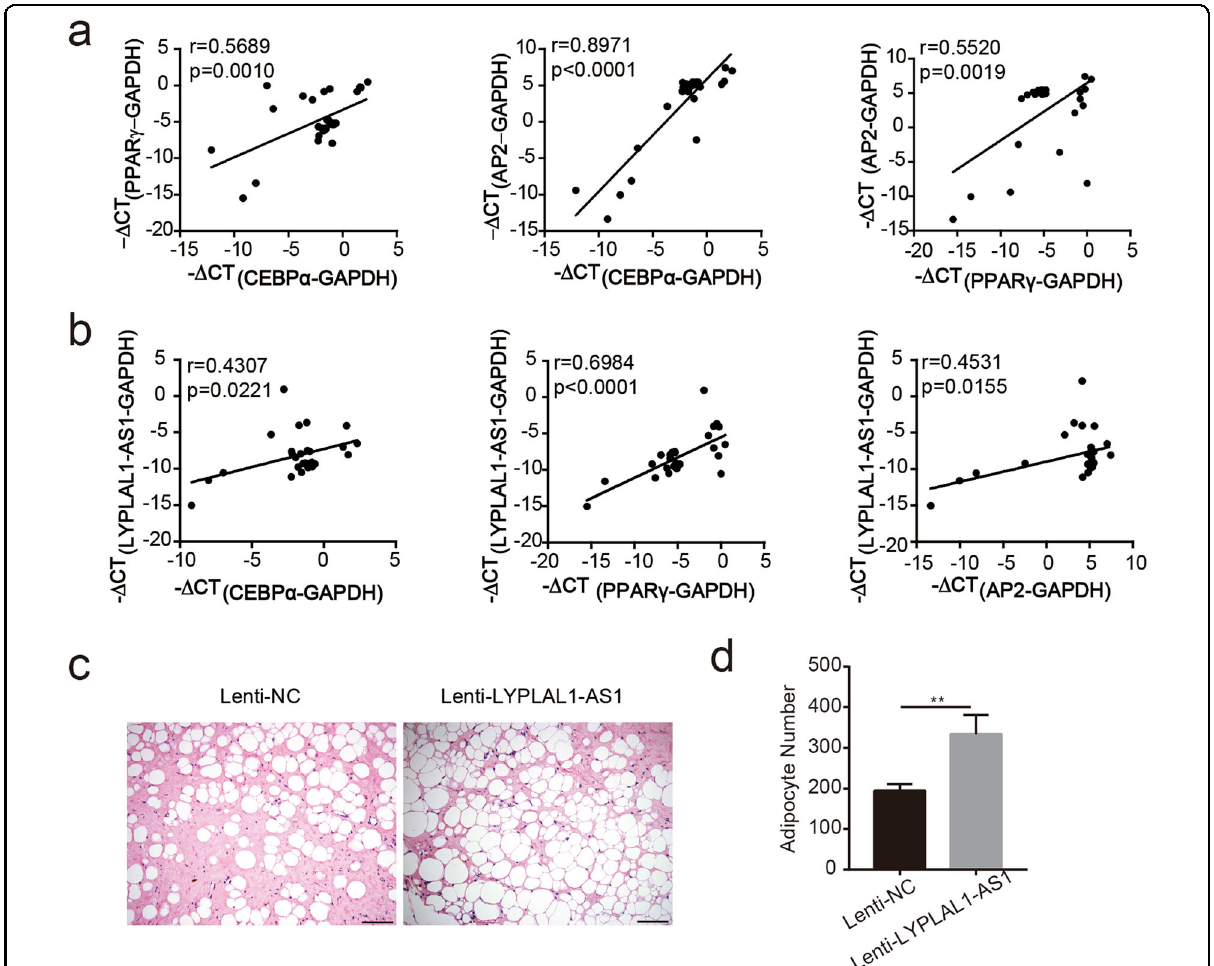
Fig. 3 LYPLAL1-AS1 is positively correlated with adipogenic markers in human adipose tissues and promotes de novo adipogenesis in vivo. a qRT-PCR analysis of adipogenic markers (PPAR γ , AP2, and CEBP α ) and the correlation analysis for each marker pair among 28 clinical adipose tissue samples. The internal control was GAPDH. b qRT-PCR analysis of LYPLAL1-AS1 and adipogenic markers (PPAR γ , AP2, and CEBP α ) among 28 clinical adipose tissue samples. c , d Representative H&E staining images for de novo adipogenesis in NOD/SCID nude mice injected with the indicated hAMSCs ( c ) and quanti fi cation of the number of adipocytes 8 weeks after injection ( d ). The quantitative data were normalized to GAPDH, n = 3; data are shown as the mean ± SD, n = 28; ** P < 0.01; scale bars: 200